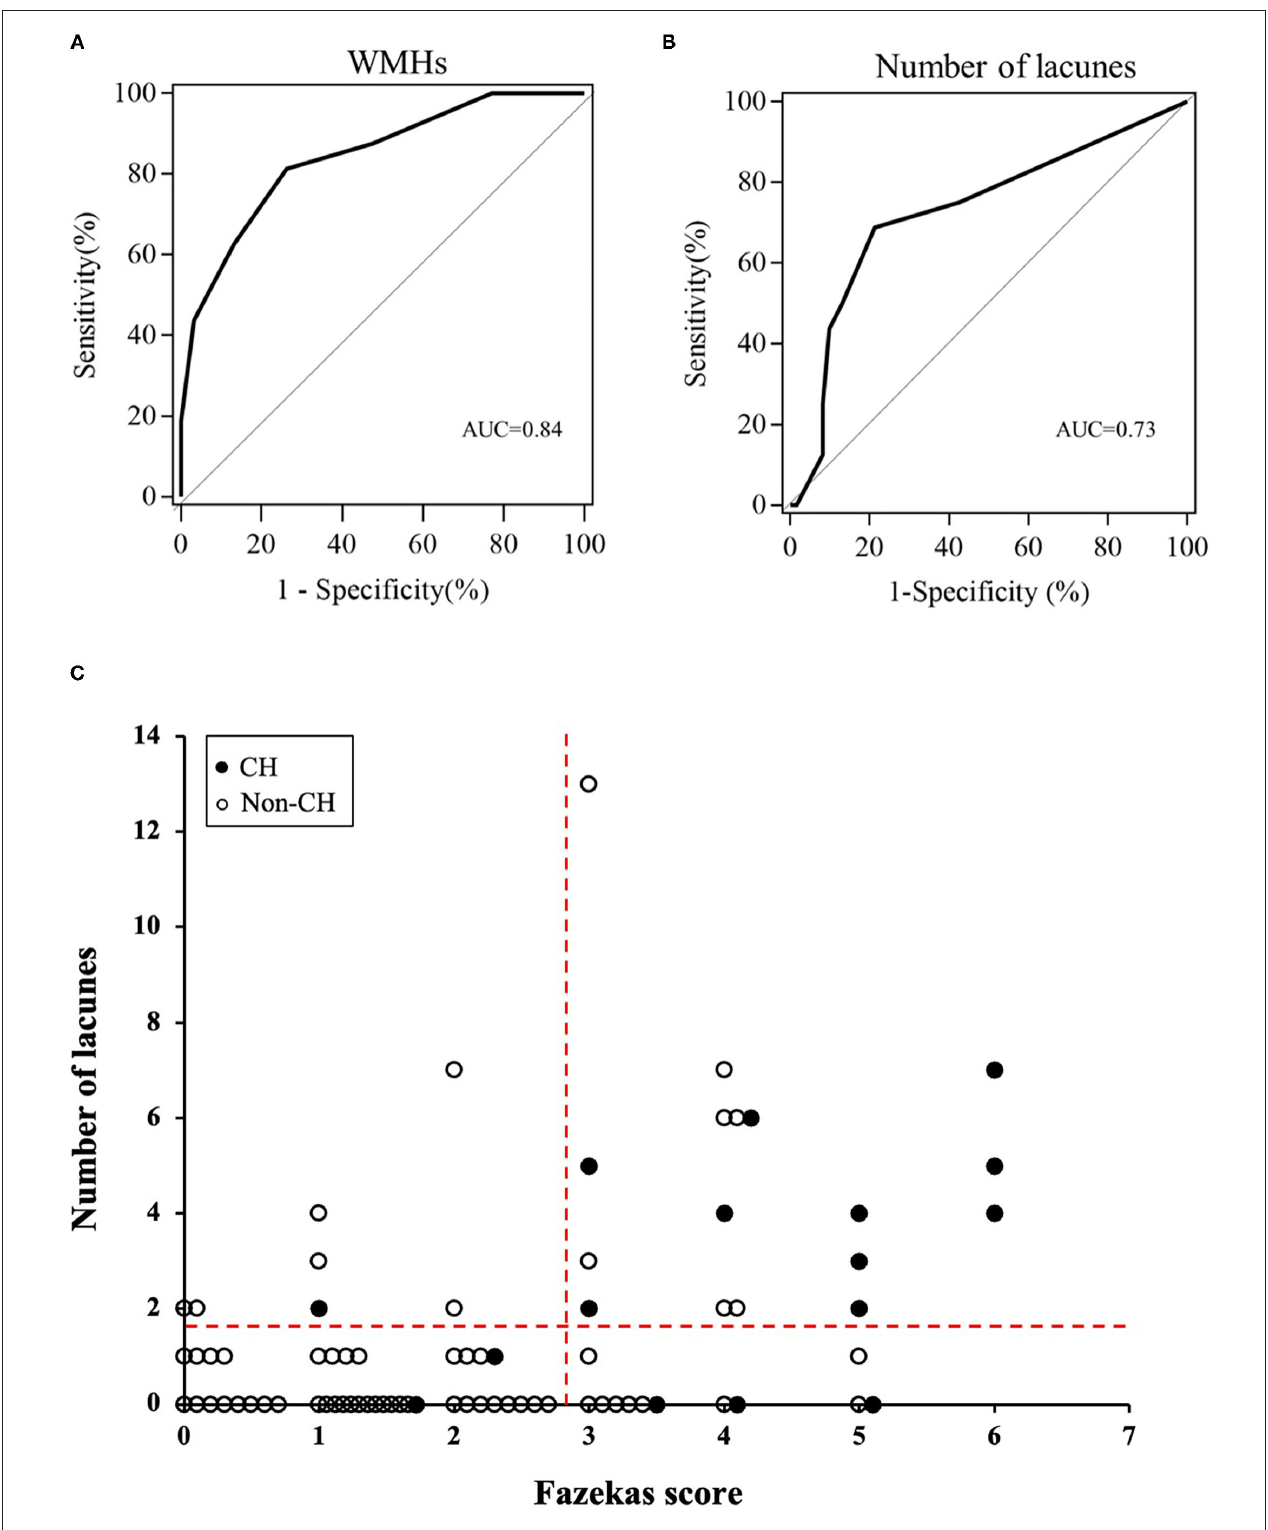
FIGURE 2 | The receiver operating characteristic (ROC) curves of pre-operative Fazekas score (A) and number of lacunes (B) for the prediction of cerebral hyperperfusion (CH) after surgery. (C) Relationships between the Fazekas score, number of lacunes, and post-operative CH. The dotted horizontal line denotes the cutoff value of lacunes ( ≥ 2) obtained from the ROC curve for prediction of CH. The dotted vertical line denotes the cutoff value of Fazekas score ( ≥ 3) obtained from the ROC curve for prediction of CH.